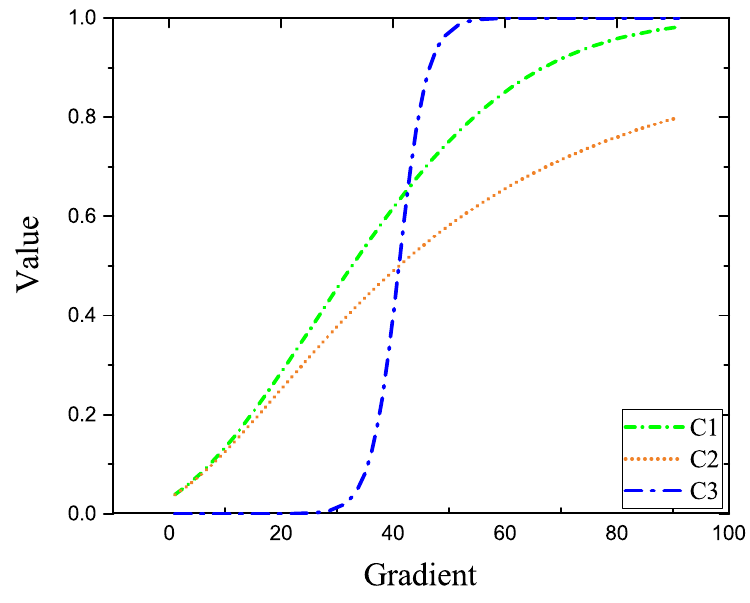
Figure 1. Gradient perception curve of kernel